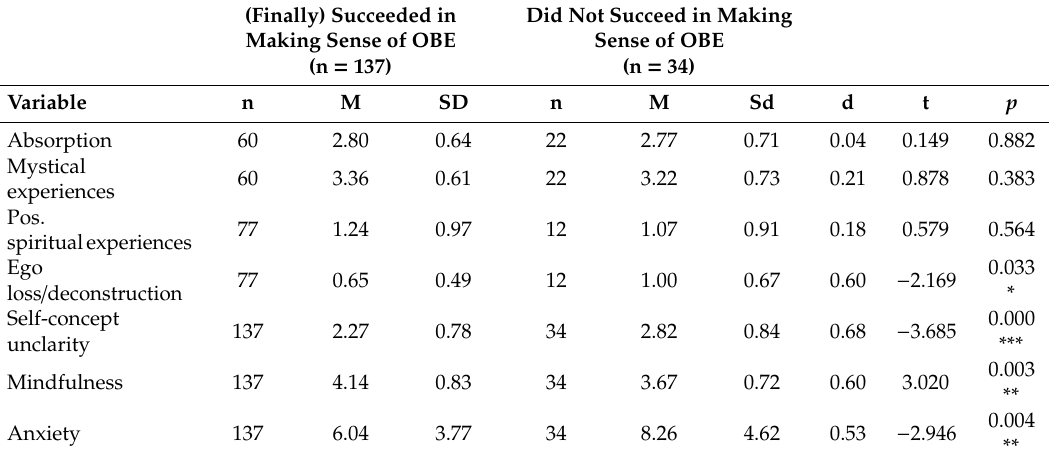
Table 4. t -tests of Mean Di ff erence between respondents who did or did not succeed in making sense of the